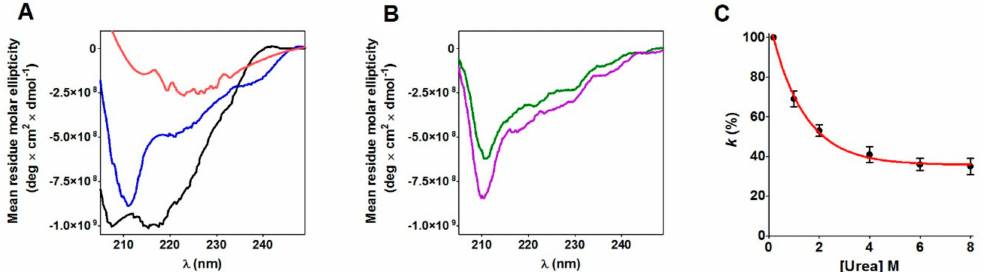
Figure 6. Circular dichroism spectra of the RNase and the e ff ect of urea on the hyper-reactivity of rRNase cysteines. ( A ) CD spectra of native ribonuclease (black line); reduced RNase in 0.2 M urea (blue line); reduced RNase in 8 M urea (red line). CD spectra were recorded at pH 7.4 (see Materials and Methods). ( B ) CD spectra of alkylated rRNase (green line); glutathionylated / alkylated rRNase (magenta line). CD spectra were recorded in 0.2 M urea at pH 7.4 (see Materials and Methods). ( C ) Hyper-reactivity of rRNase cysteines (10 µ M) toward DTNB (20 µ M) at di ff erent urea concentrations (pH 5.0, 25 ◦ C) (fit obtained using equation (5)). Average ± SD from three independent